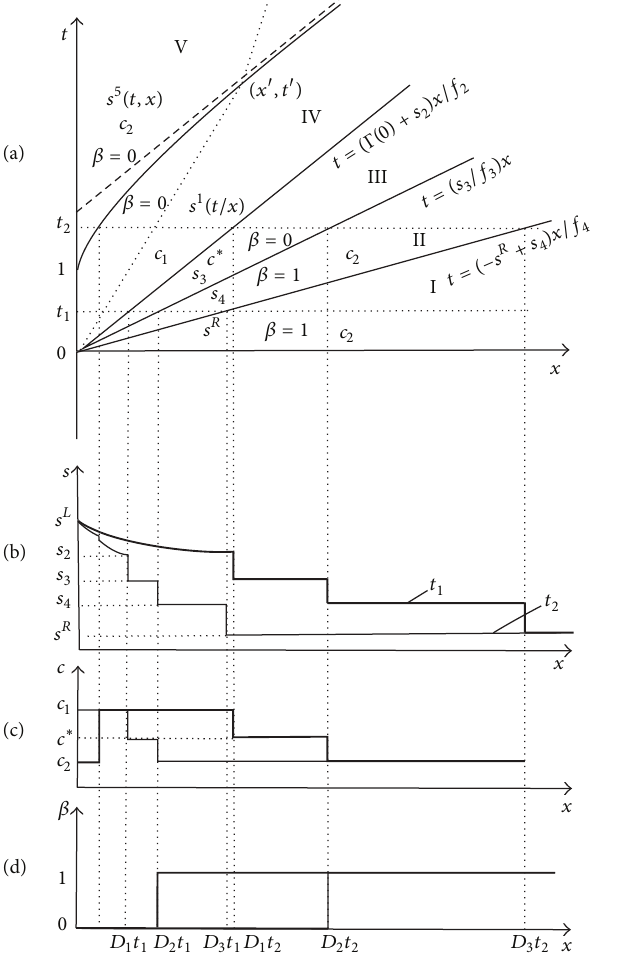
Figure 11: The solution of the slug injection problem: (a) trajectories of shock fronts and characteristic lines in (𝑥,𝑡) -plane; (b) saturation profile; (c) chemical concentration profile; (d) salinity profile.